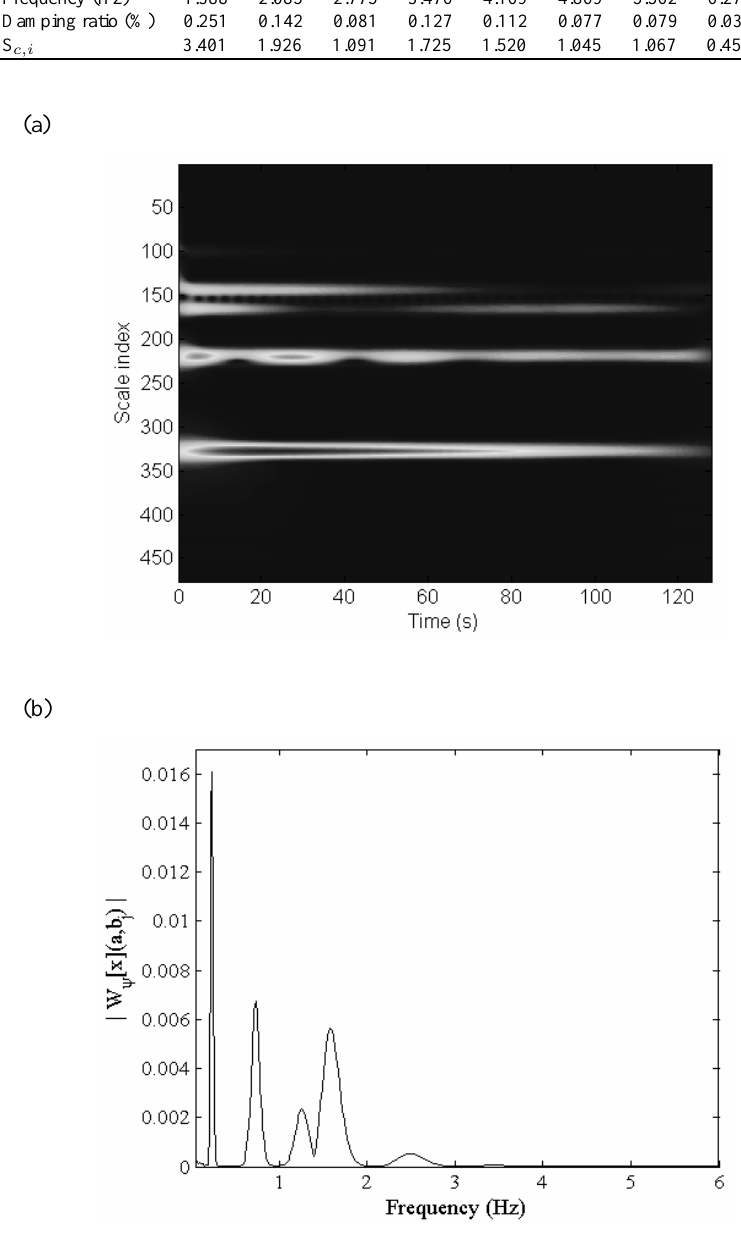
Fig. 3. (a). Wavelet transform amplitude (b) Determination of